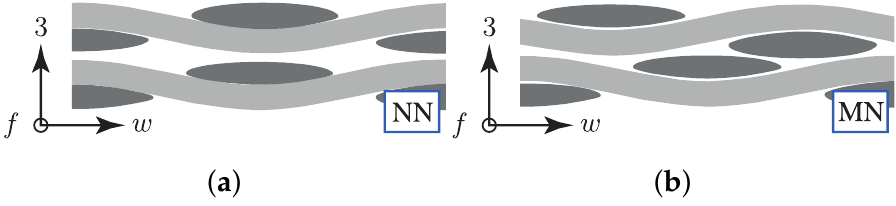
Figure 12. Illustration of the two idealistic configurations: ( a ) no nesting (NN) and ( b ) maximum nesting (MN) of textile reinforcements.